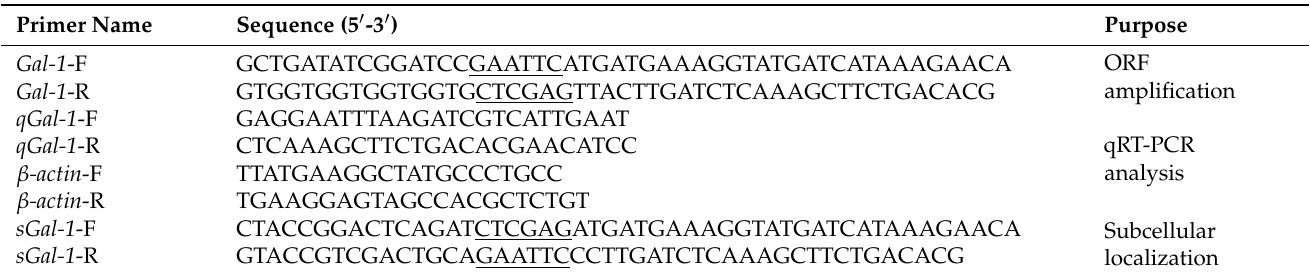
Table 2. Primers used in this